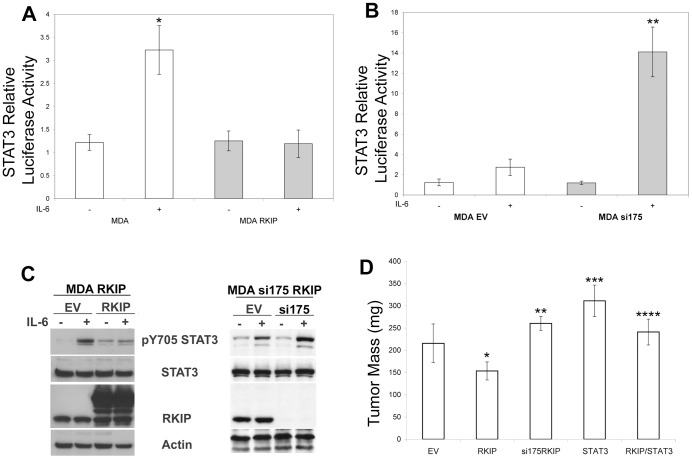
RKIP is required to inhibit STAT3 activation and breast tumor xenograft growth.(A) STAT3 luciferase reporter activity was performed as described in Figure 2 in cells treated with 40 ng/ml IL-6 for 6 h. A, represents MDA RKIP cells and (B) MDA si175 RKIP knockdown cells. Paired t-test was performed; *(p<0.007) in IL-6 treated cells when compared to EV control. Luciferase reporter activities for duplicate of 2 representative experiments +/- s.d. are shown. (C) Western blot analysis was performed in MDA RKIP and MDA si175 RKIP treated with 40 ng/ml IL-6 for 2 h. Whole cell lysates were examined for the expression of the indicated proteins. (D) MDA cells were implanted s.c. in the dorsal flanks of Nu/J female mice. Tumors were measured using calipers twice weekly, and volumes were calculated using the formula: weight (mg)  =  [width (mm)2 × length (mm)]/2. A paired t-test was performed indicating the decrease of RKIP *(p<0.002) or increase of **(p<0.008) si175RKIP, ***(p<0.002) STAT3 of tumor growth when compared to EV. A decrease in tumor growth was detected between STAT3 and RKIP/STAT3 ****(p<0.009). Mean tumor size for each treatment group is plotted (n  =  6) +/− s.d.